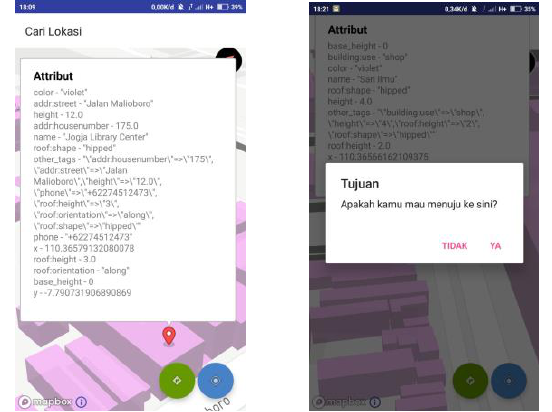
Figure 2. The identification window (left) and the confirmation window (right): do you want to go here?